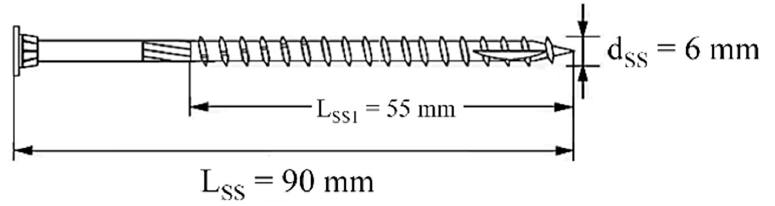
Figure 1. Self-tapping screw specifications.